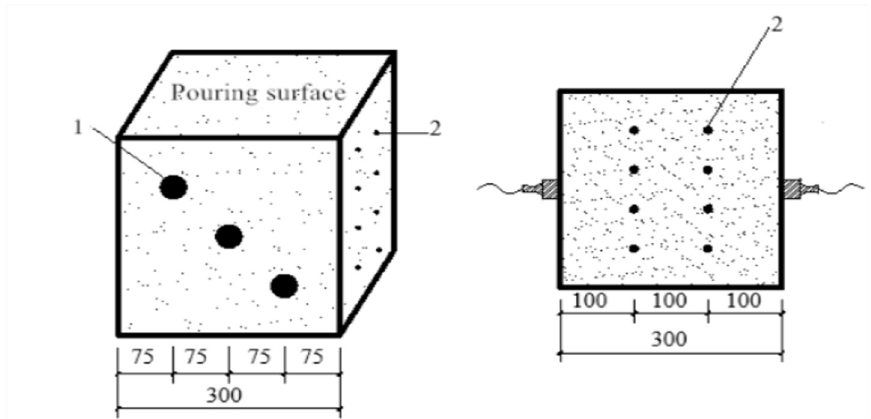
Fig 4. Distribution of ultrasonic and rebound measurement